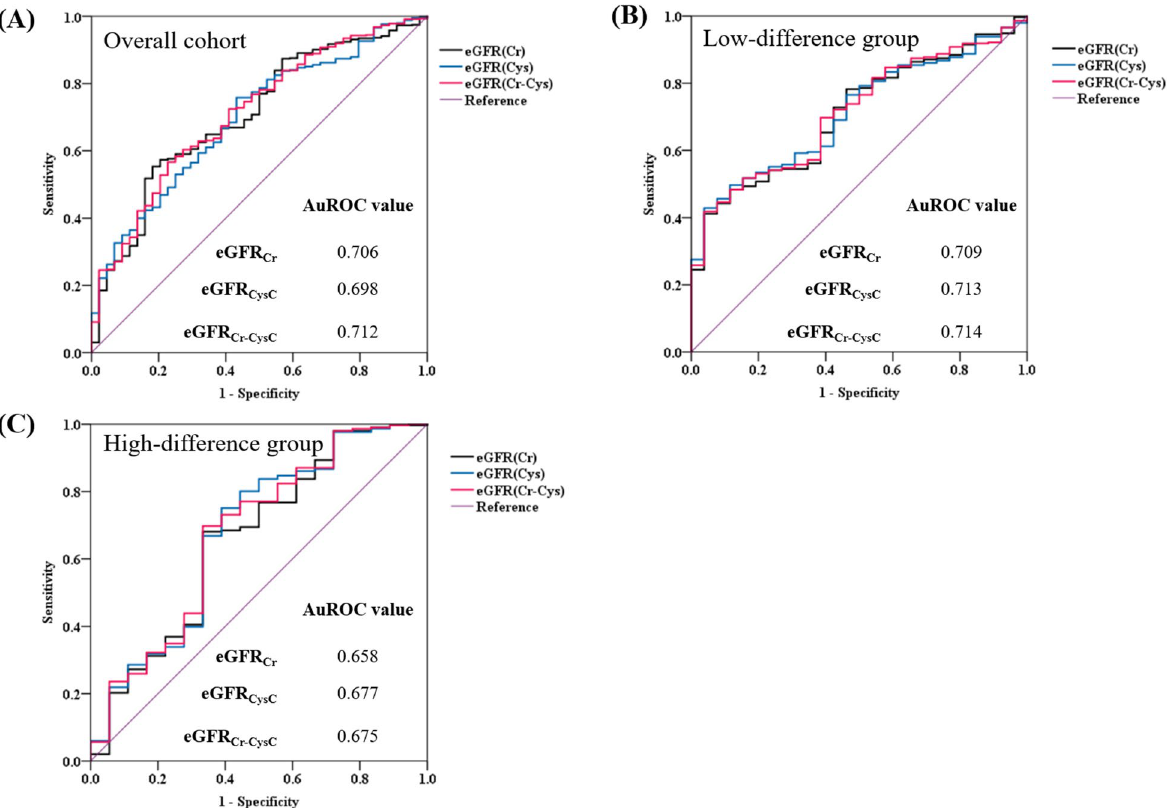
Figure 4. ROC curves and AuROC values of each eGFR equation for hyperparathyroidism with hyperphosphatemia. Panels ( A ), ( B ), and ( C ) show the ROC curves for each eGFR equation for the overall cohort, low-difference group, and high-difference group. The AuROC values of the eGFR equations are noted in each panel. AuROC, area under the ROC curve; eGFR, estimated glomerular filtration rate; eGFR Cr , eGFR based on creatinine; eGFR CysC , eGFR based on cystatin C; eGFR Cr-CysC , eGFR based on both creatinine and cystatin C; ROC, receiver operating characteristic.